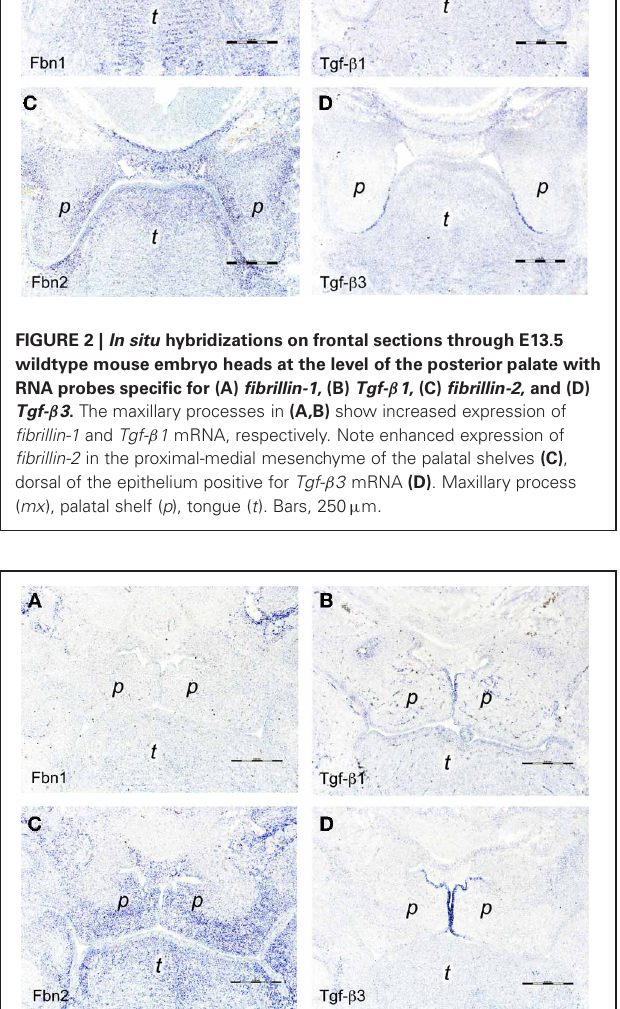
FIGURE 3 | In situ hybridizations on frontal sections through E14.5 wildtype mouse embryo heads at the level of the posterior palate with RNA probes specific for (A) fibrillin-1 , (B) Tgf- β 1 , (C) fibrillin-2 , and (D) Tgf- β 3 . Note the strong expression of fibrillin-2 in the peripheral mesenchyme of the palatal shelves (C) , adjacent to the middle edge epithelial cells that express Tgf- β 3 (D) . Palatal shelf ( p ), tongue ( t ). Bars, 250 μ